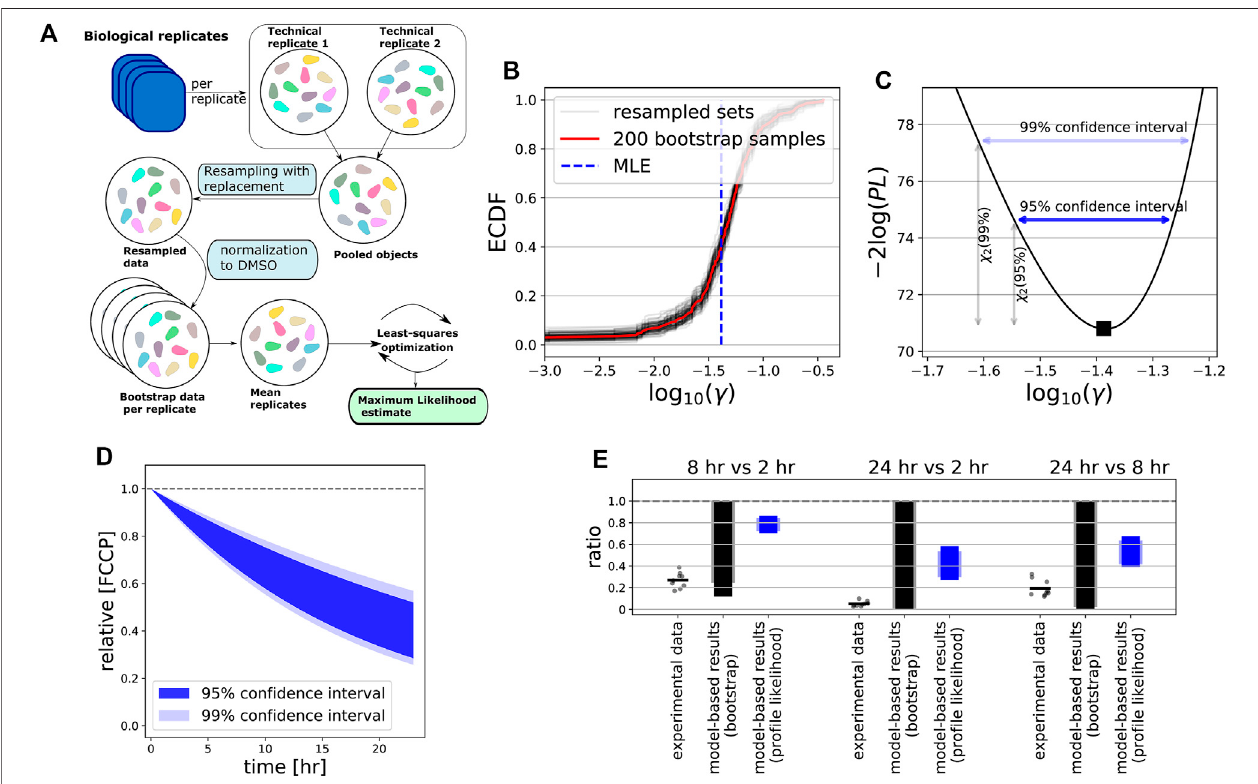
FIGURE 7 | Intracellular compound measurements con fi rms FCCP degradation over time. (A) Scheme illustrating our bootstrapping approach. Data from both technicalandbiologicalreplicateswereusedtogeneratearti fi cialdatawithrealisticintra-andinterplatevariability(see Section2 ).Arti fi caldatawereusedforsubsequent model calibration. (B) Empiricallydetermined cumulativedistribution function(ECDF)oftheestimated c valuesfor bootstrapped data.RedlineshowsECDFbased onall 200bootstrap samples,graylinesshow100resampledbootstrapsets (withreplacement),and verticalbluedashed lineindicatestheestimated MLEoftheoriginal data. (C) Pro fi lelikelihoodfor c ,wherehorizontaldarkblueandlightbluearrowsindicateits95and99%con fi denceinterval. (D) Model-predicted FCCPdynamicswithin cells basedon95%(dark blueshading) and99%con fi denceinterval(lightblueshading)ofestimated c ,withpro fi le-likelihood-basedCIs. (E) Ratiosbetweentimepoints 2, 8 and 24 h (all possible combinations) of the LC-MS/MS-based intracellular concentrations of FCCP after exposure to a concentration of 10 μ M (dots indicate all possible values of the ratios based on separate measurements, and bars indicate the mean of all these ratios) and of the model-based CIs for the ratios. The model- basedCIseitherresultfrombootstrapping(gray)orfromthepro fi lelikelihoodanalysis(blue),withthedarkcoloursbasedon95%CIsandlightcoloursbasedon99%CIs.